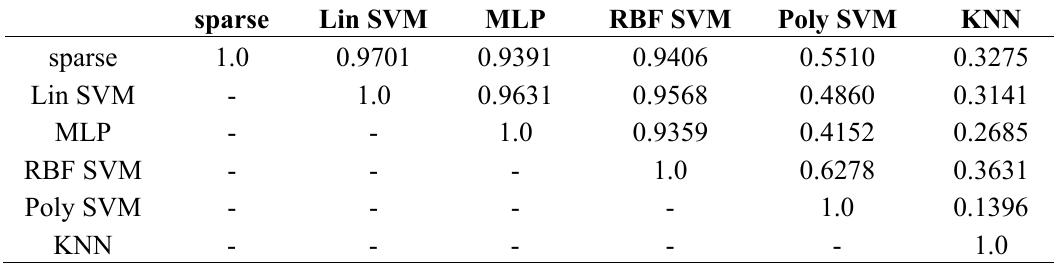
Table 2. Correlation of predictions between regression models.